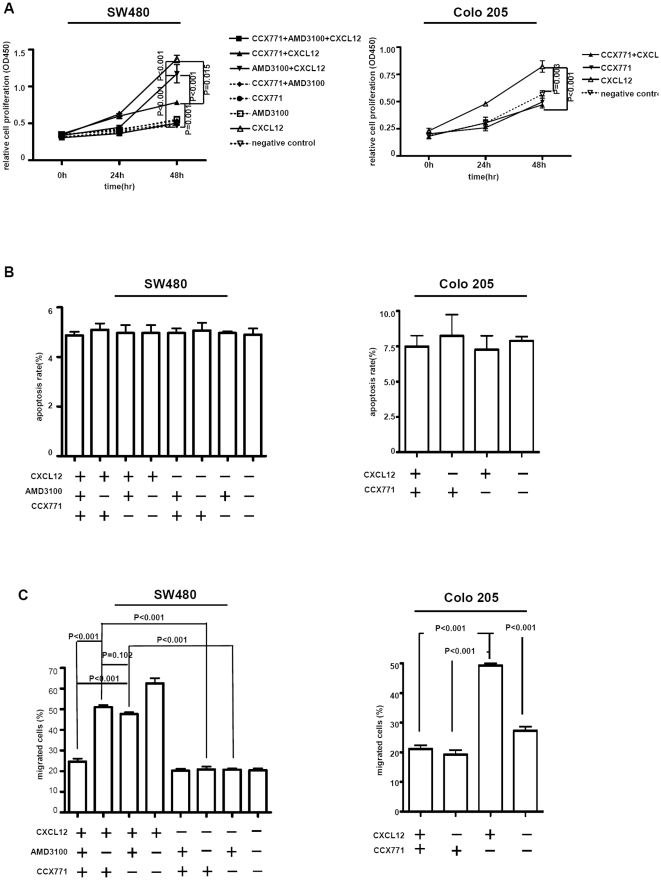
Proliferation, apoptosis and migration of CXCR7-positive SW480 and Colo 205 cell lines incubated with LPS.A, Incubation with LPS, SW480 cell line pretreated with AMD3100 (10 µg/ml) proliferated significantly in response to CXCL12 (100 ng/ml; 48 h), Colo 205 cell line also proliferated significantly in response to CXCL12. B, CXCL12 activation of its receptor CXCR7 did not exert an antiapoptotic effect. C, Pretreatment with AMD3100, SW480 cell line migrated significantly more in response to CXCL12 after 24 h of incubation with LPS, Colo 205 cell line also migrated significantly in response to CXCL12.